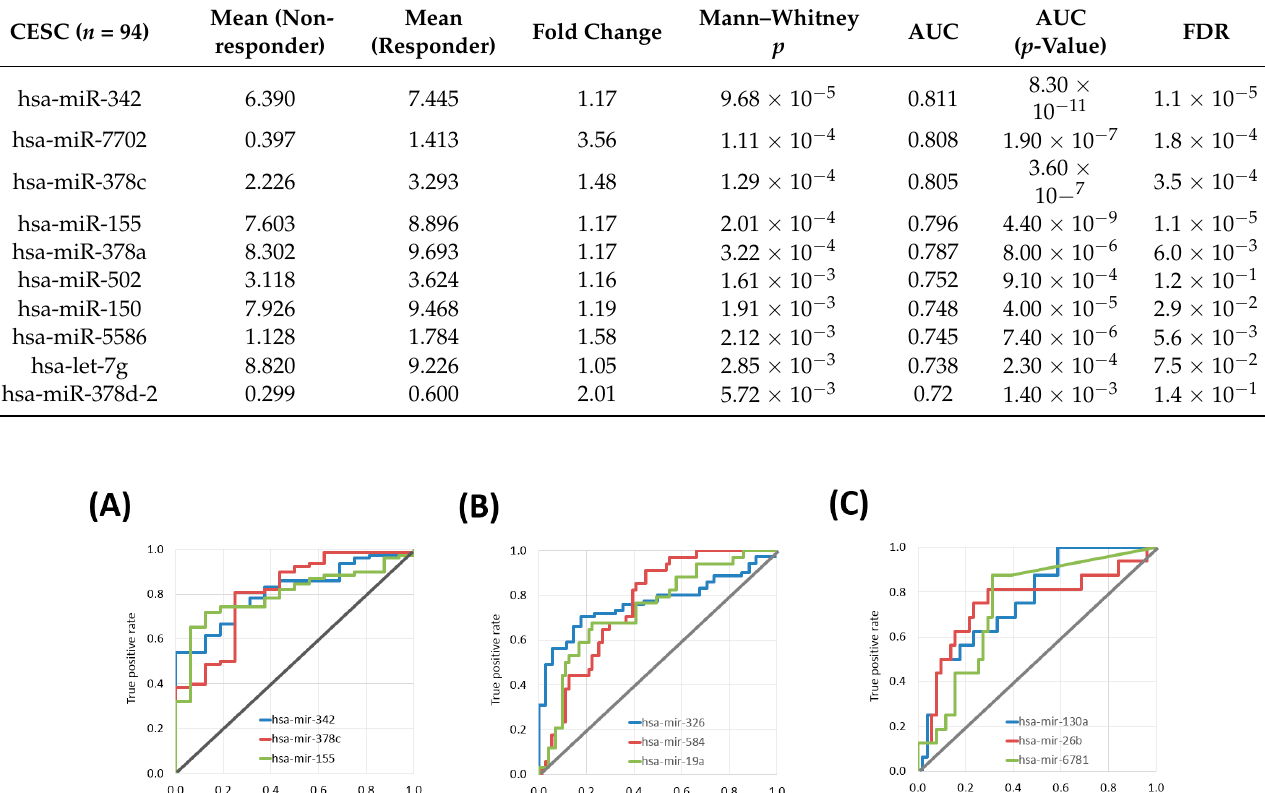
Table 2. Top ten miRNA biomarker candidates of platinum-based therapy in cervical cancer (CESC).